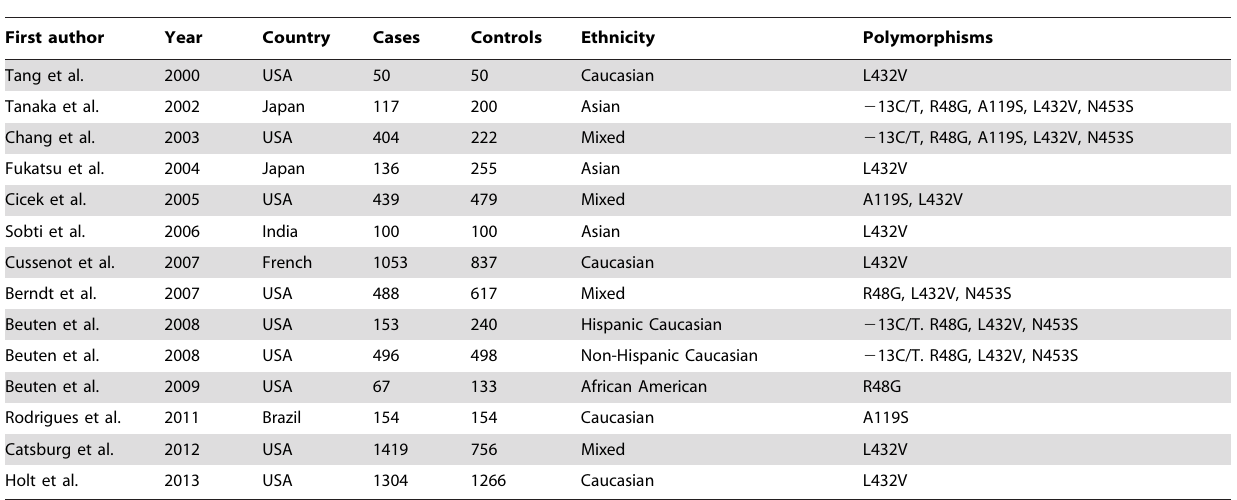
Table 1. Main characteristics of studies included in this